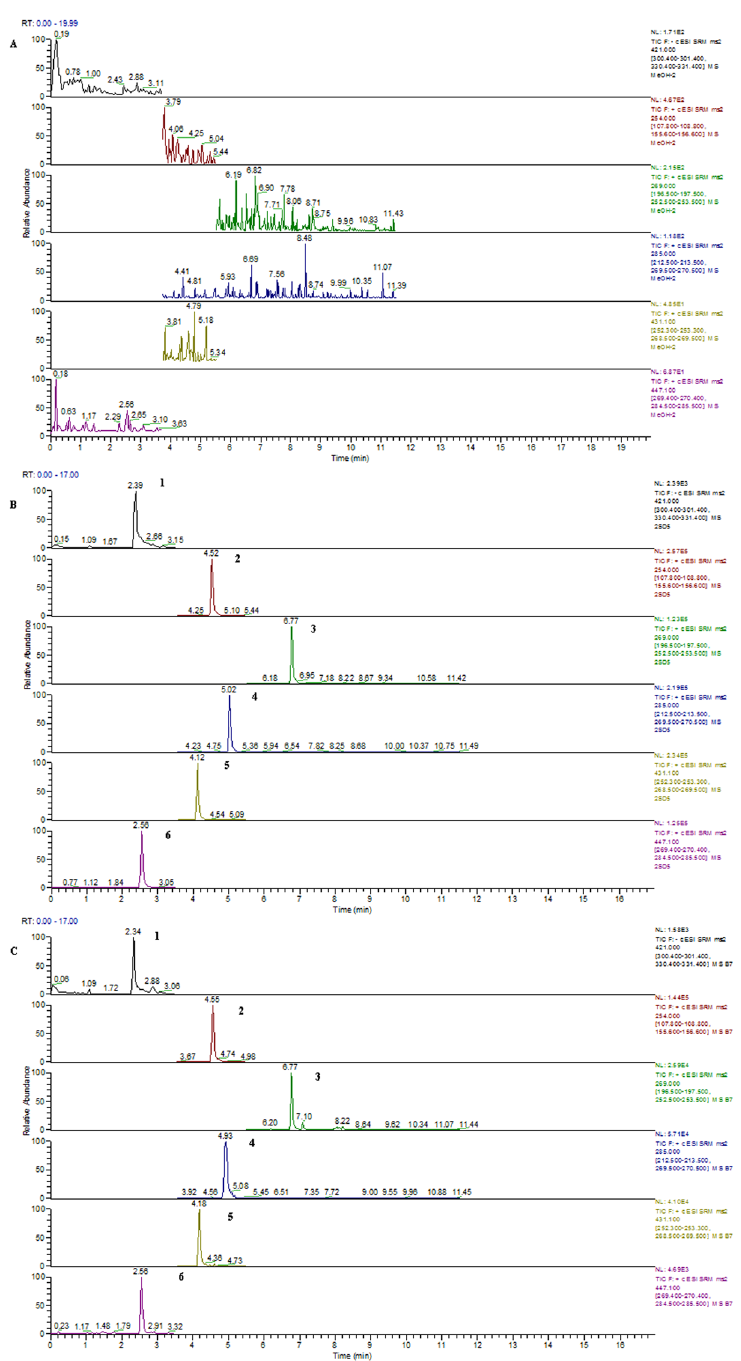
Figure 7. Typical MRM chromatograms of a blank rat plasma sample ( A ), a blank rat plasma spiked with calycosin, calycosin-7-O-glucoside, formononetin, ononin and mangiferin ( B ), and a rat plasma after the oral administration of PRM ( C ). 1: mangiferin, 2: sulfamethoxazole (IS), 3: formononetin, 4: calycosin, 5: ononin, 6: calycosin-7-O-glucoside. The original chromatograms are presented in Supplementary information